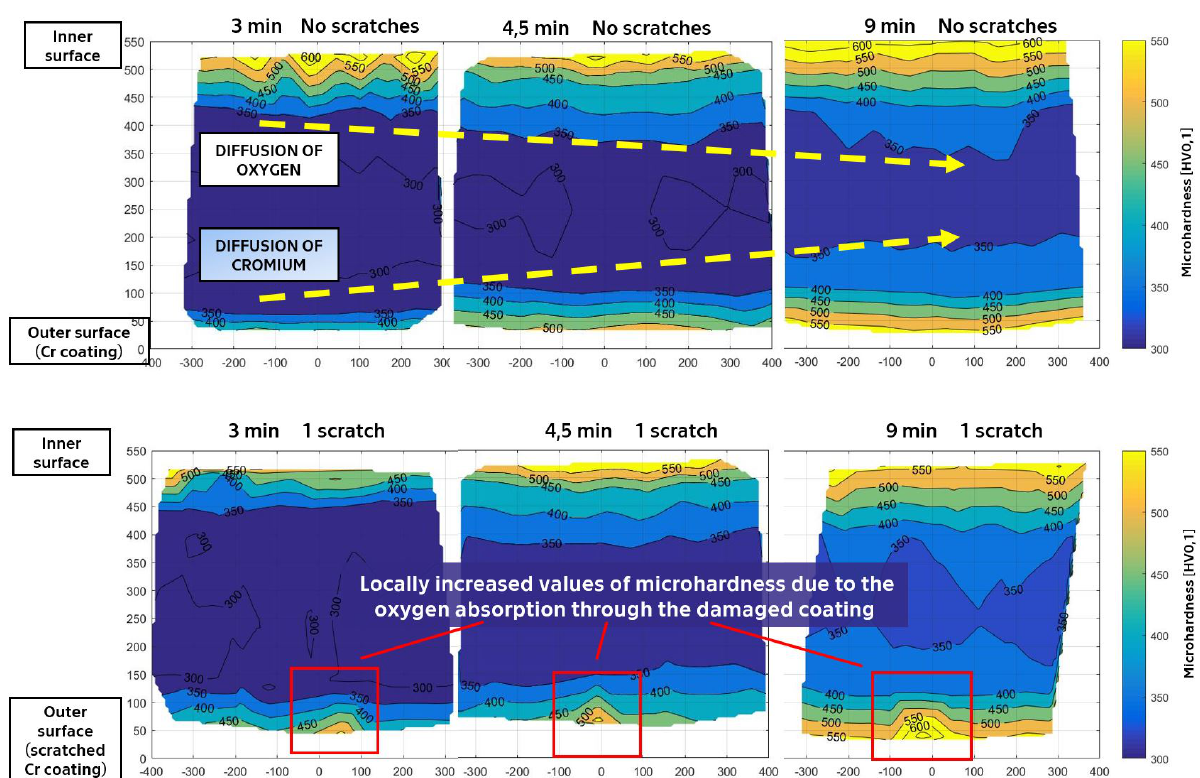
Figure 14. Surface plots of microhardness.